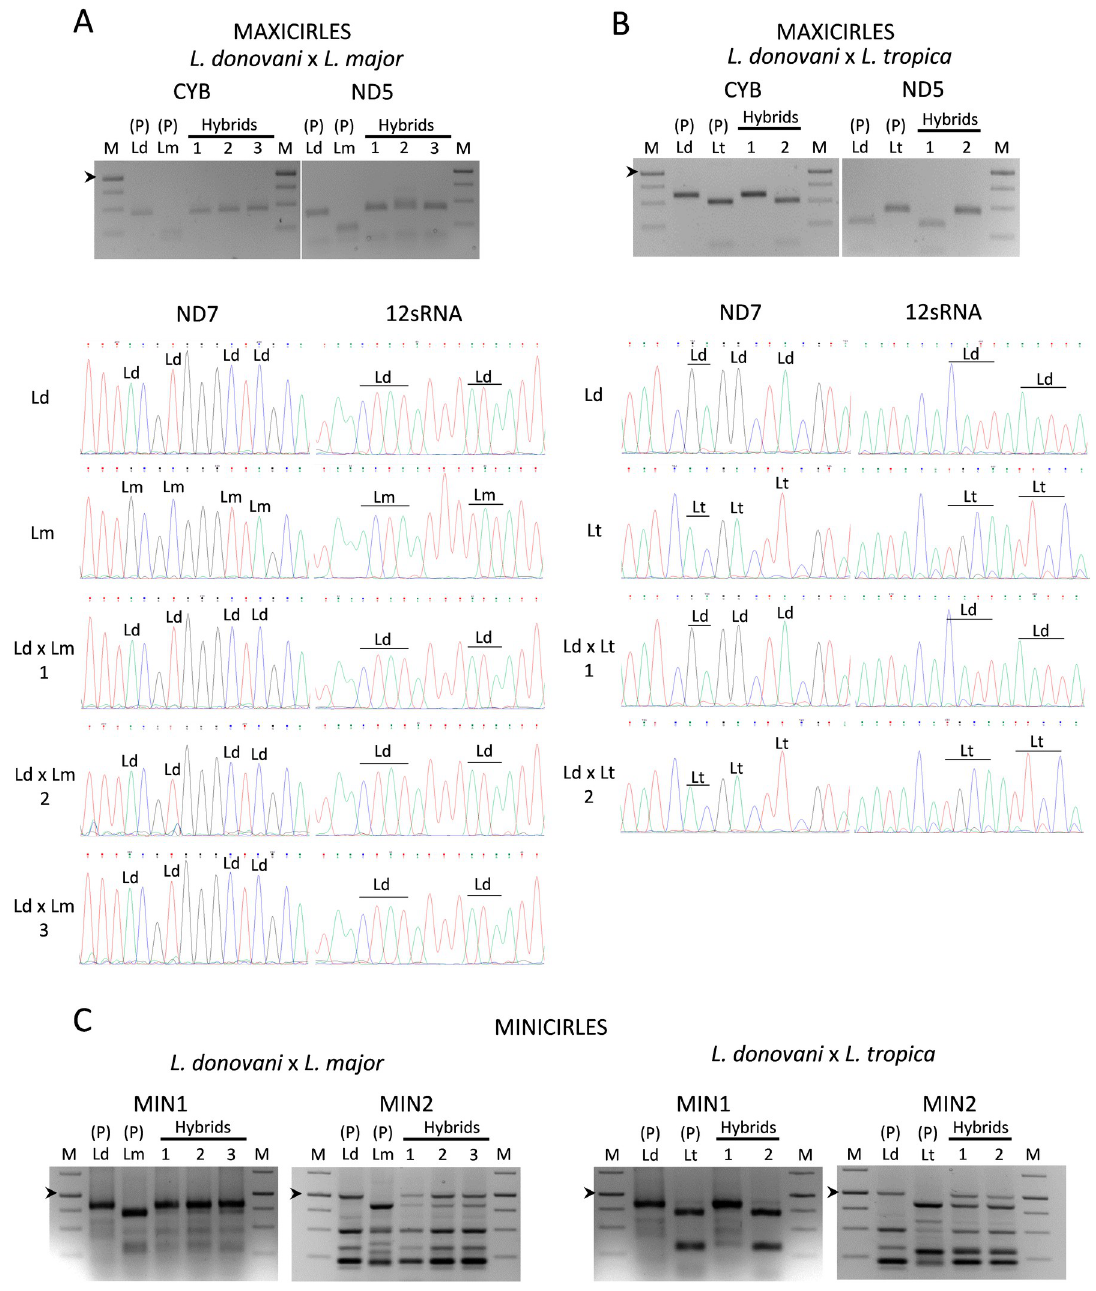
Fig 7. Characterization of the inheritance of kDNA in the interspecies hybrid clones. (A, B, top panels) Agarose gels of the SNP-CAPs analysis showing the DNA products after PCR amplification and enzymatic digestion of Cyb and ND5 genes. The electrophoretic profile of the parental lines [P (Ld, Lm)] and three hybrids [Hybrids (1, 2, 3)] resulting from the outcrossing of L . donovani mCh HYG (Ld) x L . major CTN PAC (Lm) (A), or the parental lines [P (Ld, Lt)] and two hybrids [Hybrids (1, 2)] resulting from the outcrossing L . donovani mCh HYG (Ld) x L . tropica iRFP PAC (Lt) (B), are shown. (A, B bottom panels) Fluorograms showing the sequence of part of the ND7 and 12 sRNA genes with some SNPs, which have been indicated as Ld ( L . donovani ) and Lm ( L . major ) in the parental strains L . donovani mCh HYG (Ld), L . major CTN PAC (Lm) and in their clonal hybrids (LdxLm) 1, 2 and 3 (A), or as Ld ( L . donovani ) and Lt ( L . tropica ) in the parental strains L . donovani mCh HYG (Ld), L . tropica iRFP PAC (Lt) and in their clonal hybrids (LdxLt) 1 and 2 (B). (C) Agarose gels showing the band profile after amplification of a conserved region (MIN1) or a variable region (MIN2) of minicircles in the parental lines [P (Ld, Lm)] and three hybrids [Hybrids (1, 2, 3)] resulting from the outcrossing of L . donovani mCh HYG (Ld) x L . major CTN PAC (Lm) (left panel), or in the parental lines [P (Ld, Lt)] and two hybrids [Hybrids (1, 2)] resulting from the outcrossing L . donovani mCh HYG (Ld) x L . tropica iRFP PAC (Lt) (right panel). The arrowhead indicates 1000 bp in the DNA molecular weight marker